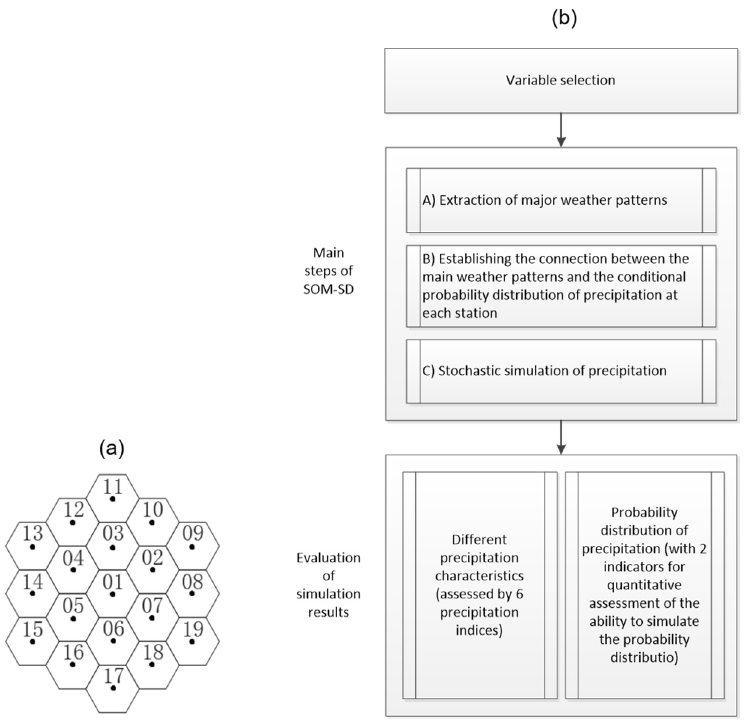
Figure 2. ( a ) Variable field interpolation (19 hexagons selected around the station). ( b ) Different methodological procedures applied in this study. methodological procedures applied in this